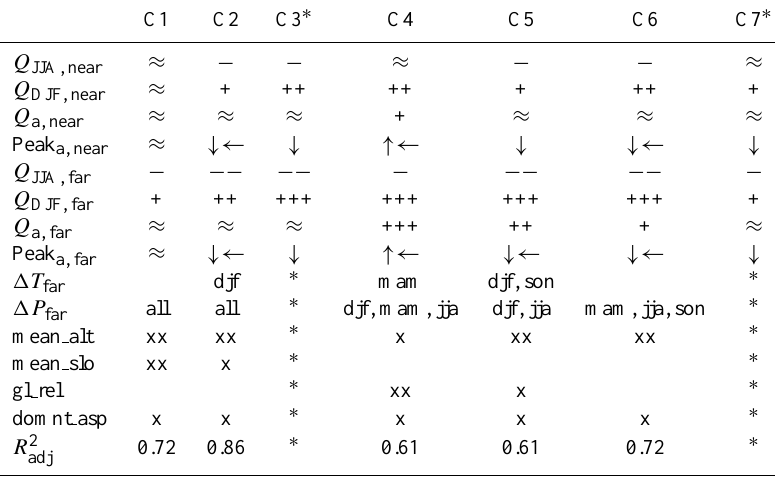
Table 2. Summary of summer (JJA), winter (DJF) and yearly (a) runoff changes ( Q ) per cluster and scenario period (near, far) and evaluation of the constraints from redundancy analysis. Explanation of symbols: increase/decrease < 10% ( ≈ ), 10–29% (+/ − ), 30–50% (++/ −− ), > 50% (+++/ −−− ). Yearly peak increased ( ↑ ), decreased ( ↓ ) or shifted earlier ( ← ). Influence of constraint (x), strong influence of constraint (xx). For influence of the climate change signal ( 1T , 1P ), the respective seasons are indicated. R 2 =proportion of variance adj explained by constraints. C1